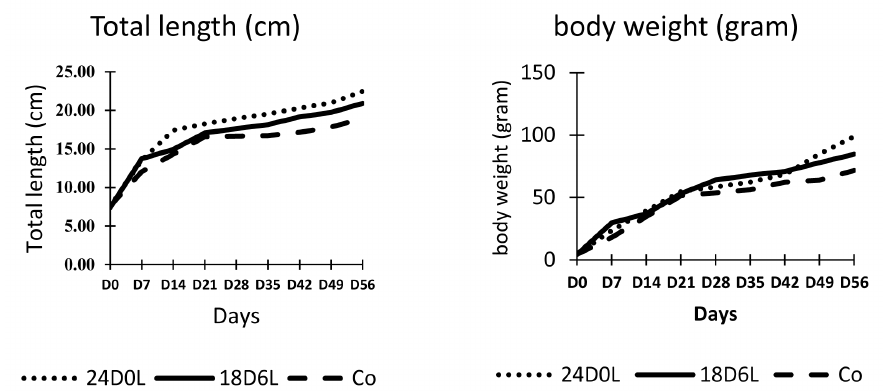
Figure 1. Total length and weight of Pangasionodon hypophthalmus reared under manipulated photoperiod. 24D0L, 24 hours of darkness; 18D6L, 18 hours of darkness; Co, control – normal